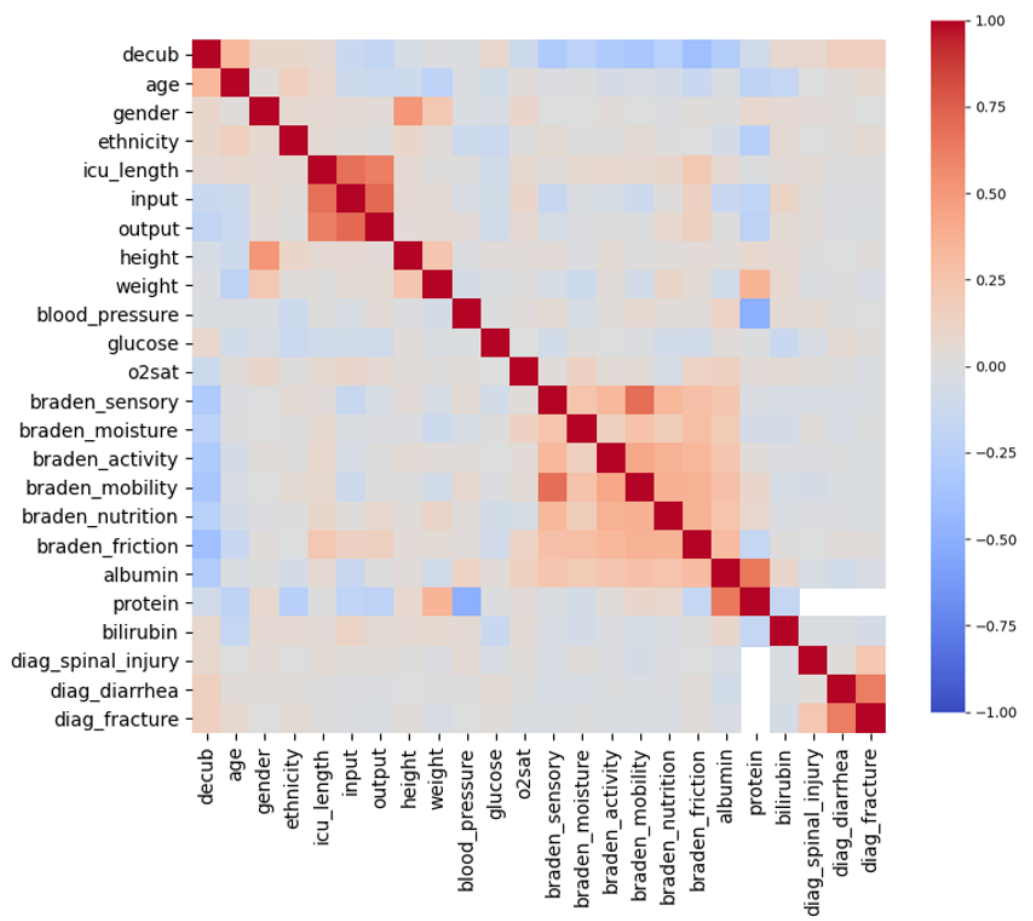
Figure 2. Correlation matrix of non-debiased input parameters.